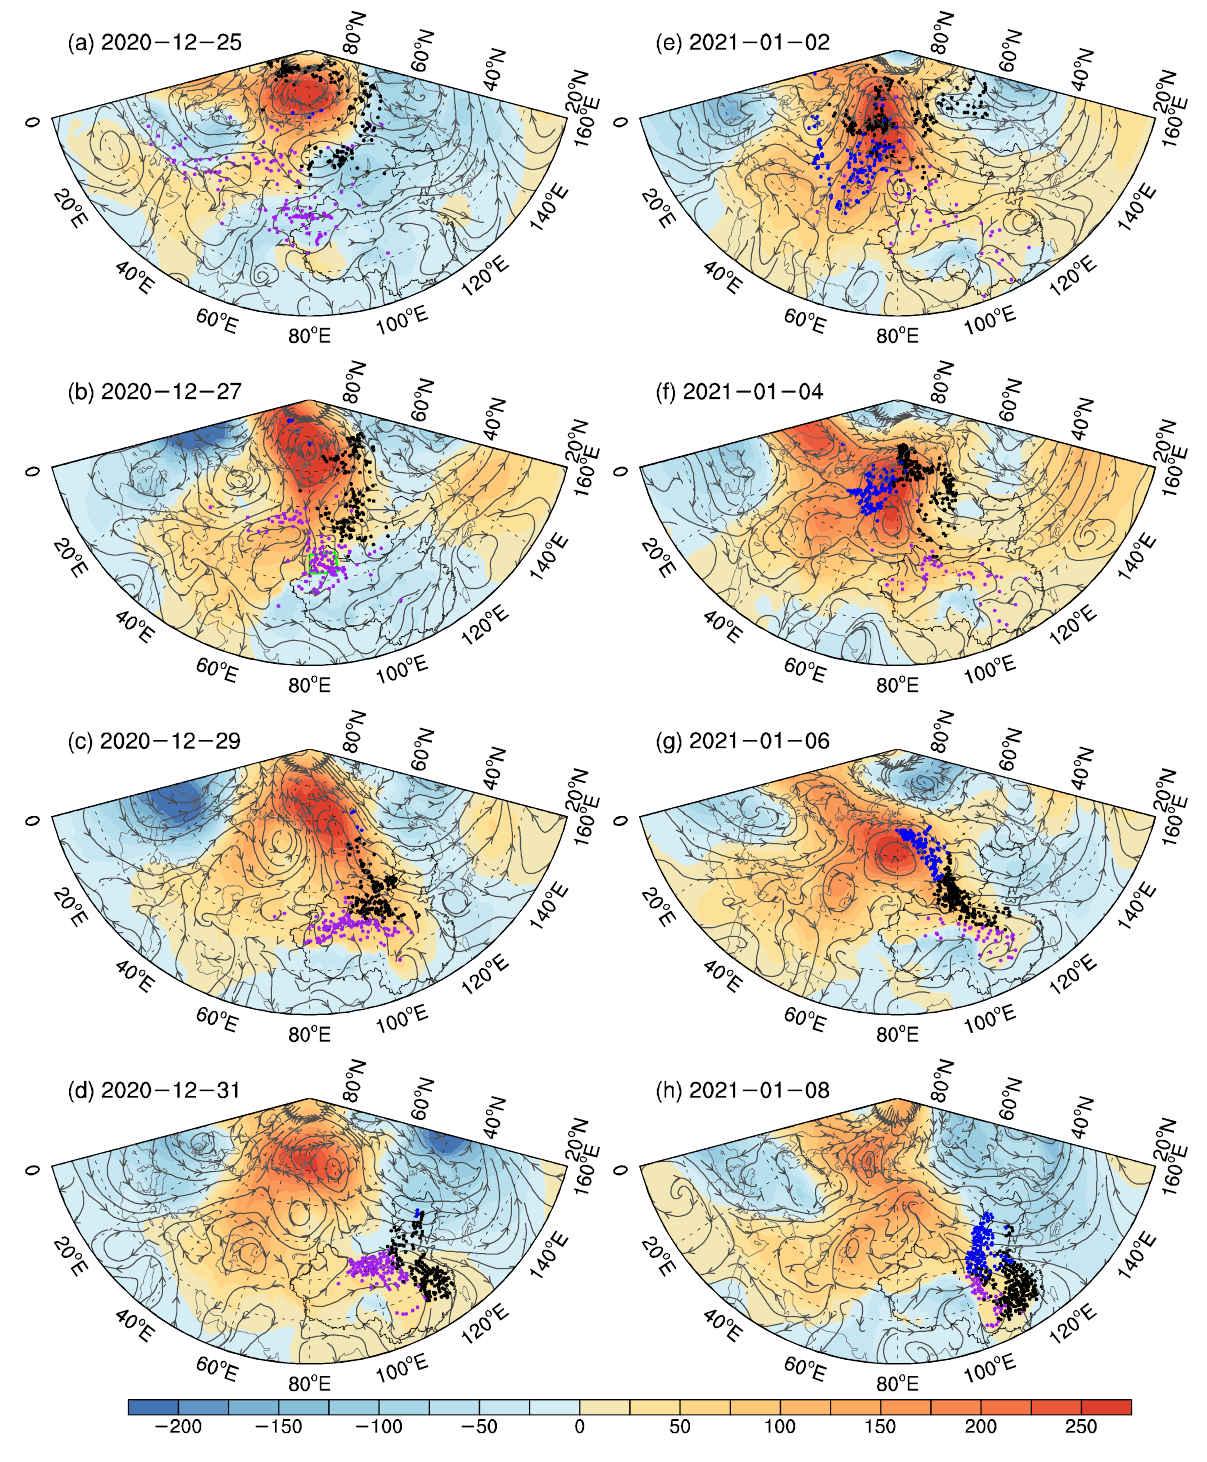
Figure 5. The geopotential height anomaly (shadings, unit: gpm) and wind stream (arrows, units: m/s) at 850 hPa on ( a ) 25 December 2020, ( b ) 27 December 2020, ( c ) 29 December 2020, ( d ) 31 De- The dots indicate the location of air mass in the corresponding day. The black, purple and blue dots represent the air masses in cluster 1, 2 and 3, respectively. The green box in (b) is the key region over (42°N – 47°N, 80°E – 90°E).